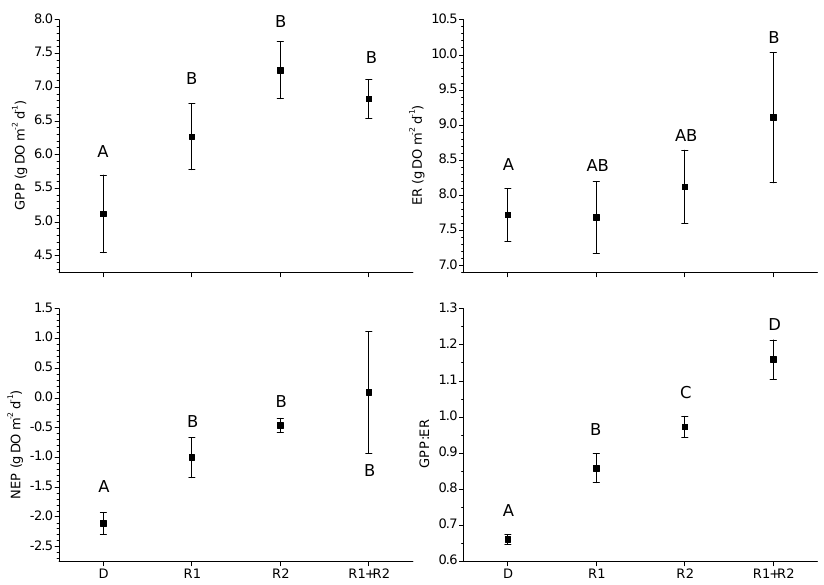
Figure 5. Average predicted metabolic parameters and 95% confidence intervals of time series estimated by the one-station open-channel method at river stations downstream of reaches D, R1, and R2, and by the two-station open-channel method for river reach R1 + R2. F tests for all variables were significant (GPP: P < 0 . 001; ER: P < 0 . 05; NEP: P < 0 . 005, GPP:ER: P < 0 . 0001). Different letters indicate differences according to Tukey’s post hoc test ( P < 0 .